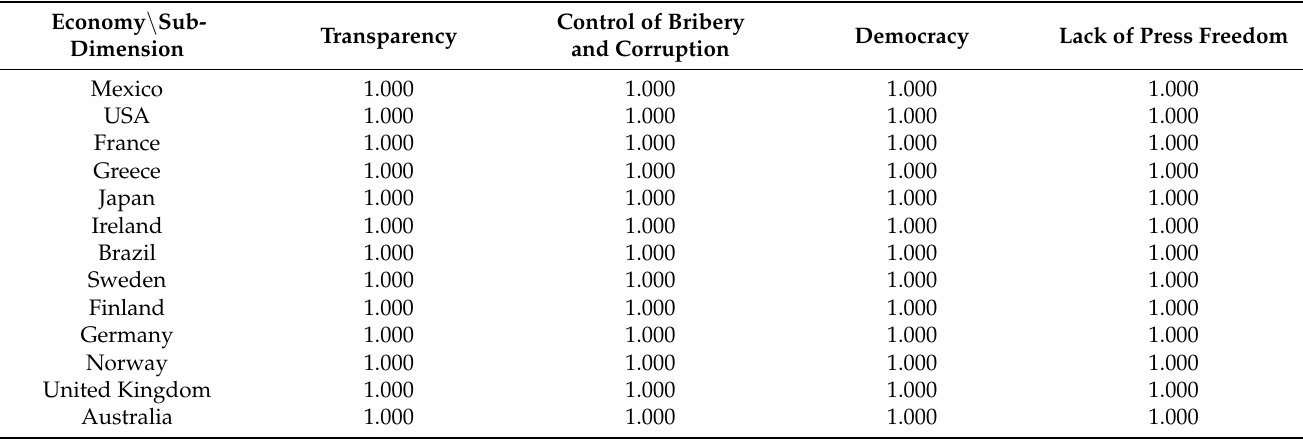
Table A2. Output efficiency in the society